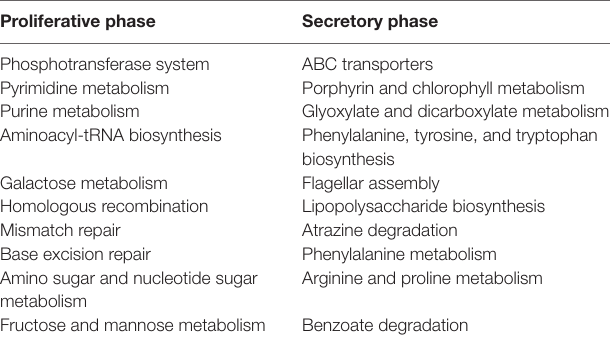
taBle 1 | Enrichment analysis of microbial KEGG pathways in the proliferative and the secretory phases in the endometrium from 80 reproductive-aged women (18) (adapted with permission from Nature Publishing